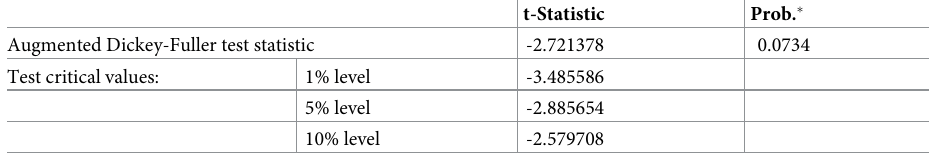
Table 2. Augmented Dickey-Fuller test